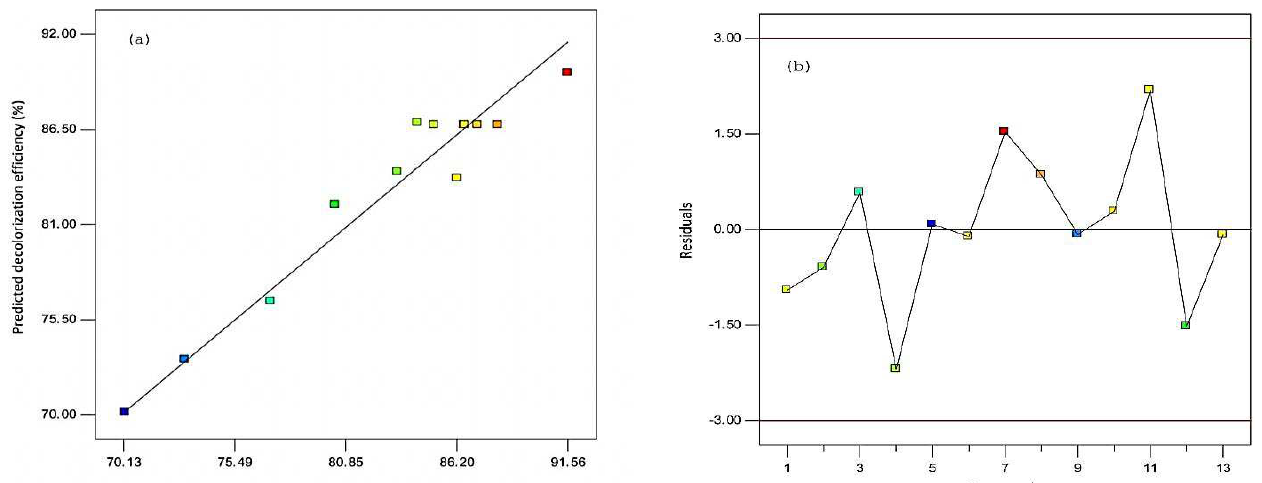
Figure 1. (a) Predicted versus actual decolorization efficiency and (b) residual versus run number for the photocatalytic methylene blue (MB)